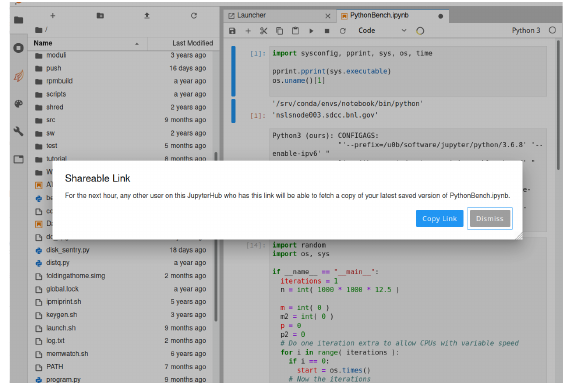
Figure 5. A temporary notebook share link is generated by right-clicking in the